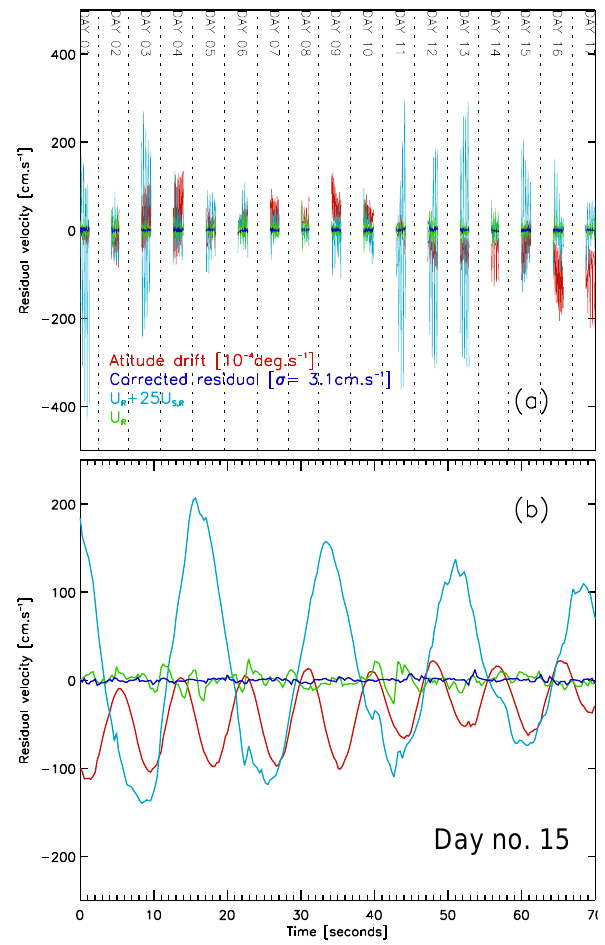
Figure B3. Velocity residual error (in cms − 1 ) for the Oregon coast simulations non-corrected (red curve) and corrected (blue curve) by removing the fit of the satellite attitude misknowledge, combining beams and eight ( γ 0 , θ 0 ) pairs by antenna rotation. (a) Simulated data over one satellite pass for day 21. (b) Results for all satellite passes in the domain shown in Fig. 6. This time frame in Septem- ber 2014 includes winds speeds up to 22ms − 1 . For each pass the duration is stretched over 20h in order to make it visible. U R and U R , S signals are also shown for scale. The satellite attitude drifts randomly (10 − 4 ◦ s − 1 ). The error induced by the satellite attitude misknowledge is higher when the geophysical signal is stronger and less